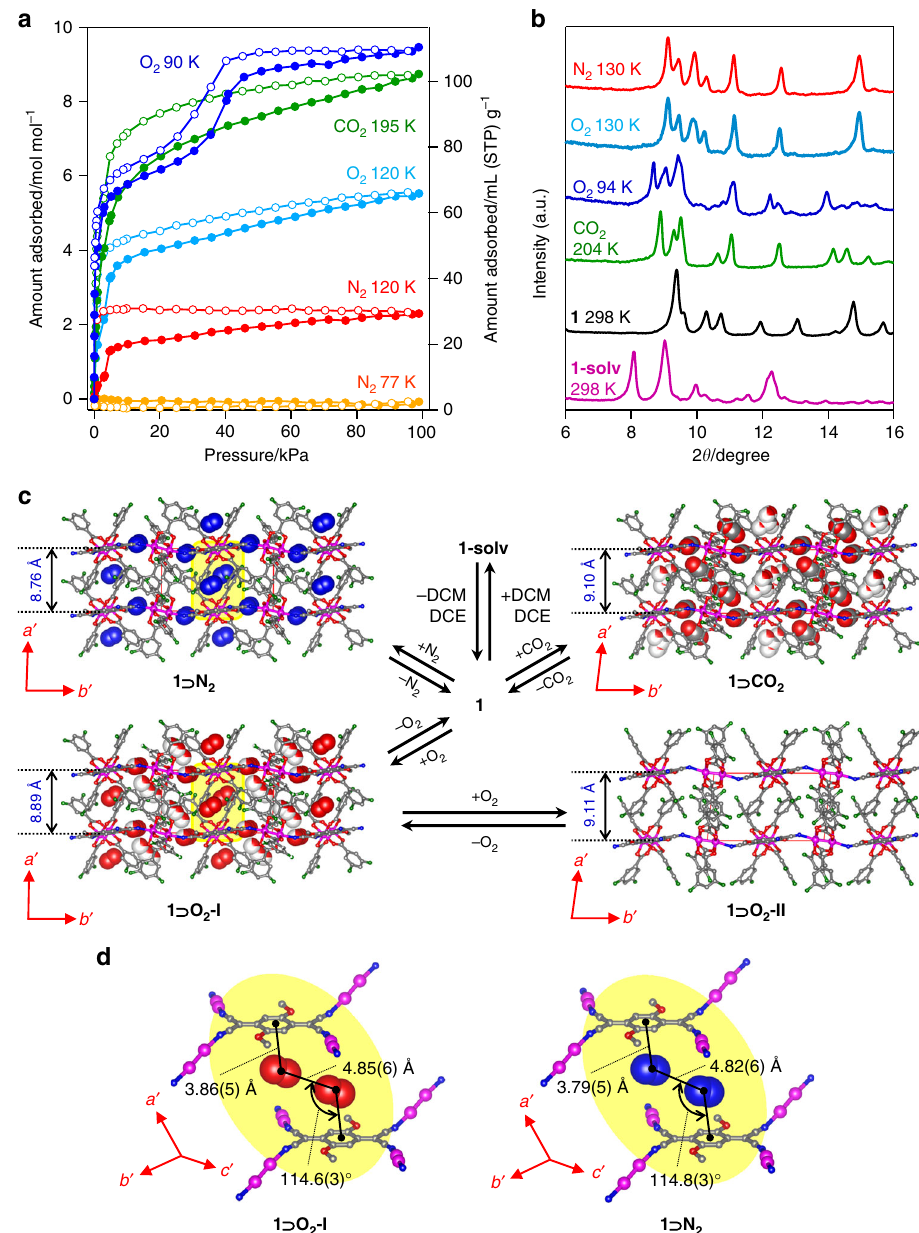
Fig. 2 Gas sorption capability, sorption-induced structural transitions, and crystal structures under gases. a Adsorption (closed) and desorption (open) isotherms of 1 for CO 2 at 195 K (green), N 2 at 77 K (orange) and 120 K (red), O 2 at 90 K (blue) and 120 K (cyan), where solid lines are only guide for the eye. b PXRD patterns measured ( λ = 1.54 Å) under 100 kPa of N 2 at 130 K (red), O 2 at 130 K (cyan) and 94 K (blue), and CO 2 at 204 K (green) and ones for 1 (black) and 1-solv (purple) at 298 K. c Packing views ( c ′ -axis projection, where atoms N, O, C, F, and Ru are represented in blue red, gray, green, and purple, respectively) of 1 ⊃ N 2 at 130 K, (upper left), 1 ⊃ O 2 -I at 130 K (lower left), 1 ⊃ O 2 -II at 94 K (lower right), and 1 ⊃ CO 2 at 195 K (upper right) and their transformation routes including 1-solv and 1 , where the structures for 1 ⊃ N 2 , 1 ⊃ O 2 -I , and 1 ⊃ CO 2 were determined by in situ SCXRD analyses, and it for 1 ⊃ O 2 -II was evaluated from the PXRD pattern with the Rietveld re fi nement (the accommodated gas molecules in a space fi lling model, of which the site occupancy is colored, are only represented in 1 ⊃ N 2 , 1 ⊃ O 2 -I , and 1 ⊃ CO 2 , and minor position-disordered components in a part of layer framework in 1 ⊃ O 2 -I were omitted for clarity). The a ′ – c ′ axes represent those of a transformed lattice for easy comparison with the lattice of 1-solv (see Supplementary Methods). The vertical inter-layer distances ( l 1 ) are indicated in blue digit, and the inter-unit translational distance ( l 2 ) corresponds to the a ′ -lattice axis for each compound (Supplementary Table 8). d A close-up view of gas-sandwiched mode at Site-A (Supplementary Fig. 10) denoted as an yellow ellipse in fi gure c for 1 ⊃ O ⊃ N 2 -I and 1 (Supplementary Fig. 6, 7, 9, and 10, Supplementary Table 4 − 6, accommodated gases were reasonably determined with occu- Supplementary Note 5 − 7), and it of 1 ⊃ O 2 -II was evaluated pancy numbers of 4N 2 , 5.2O 2 , and 5CO 2 , respectively, which were from the in situ PXRD data using the Rietveld re fi nement displayed in Fig. 2c and Supplementary Fig. 9 and 10 (the O 2 technique (Supplementary Fig. 8, Supplementary Table 7, molecules for 1 ⊃ O 2 -II have less accuracy, so only the framework Supplementary Note 6). For 1 ⊃ N 2 , 1 ⊃ O 2 -I , and 1 ⊃ CO 2 , the structure is discussed). The inter-layer distances, which are